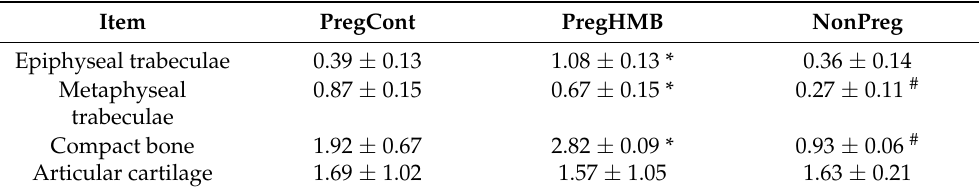
Table 5. Thin collagen content (%) in trabeculae, compact bone and articular cartilage of femora from pregnant (control and supplemented with β -Hydroxy β -methylbutyrate (HMB)) and non-pregnant female spiny mice.